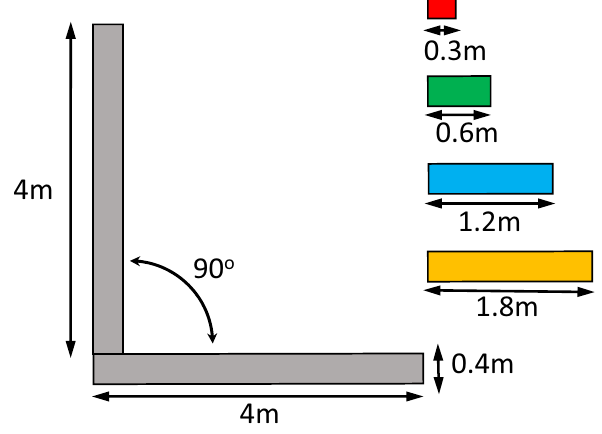
Fig. 2 Top view diagram illustrating the shape and dimensions of the wall to be built by the UGV in the second challenge of the MBZIRC 2020 competition along with the four different brick types available for the construction 1 http:// mbzirc. com/ chall enge/